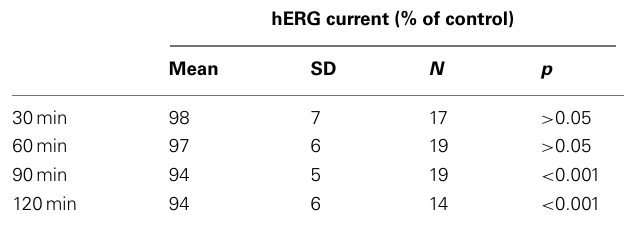
Table 1 | Effects of 0.1% (v/v) DMSO on the hERG K + current.